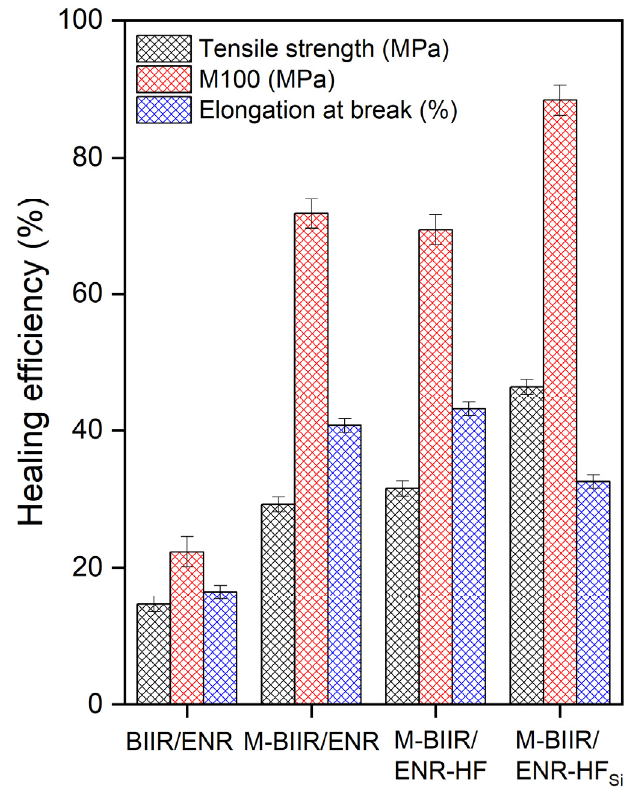
Table 5. Healing efficiency based on tensile properties, elongation at break and M100. Figure 5. Healing efficiency of unmodified BIIR and the M-BIIR/ENR composites filled with Samples CNT/CB with and without the addition of TESPT based on tensile properties, elongation at break and